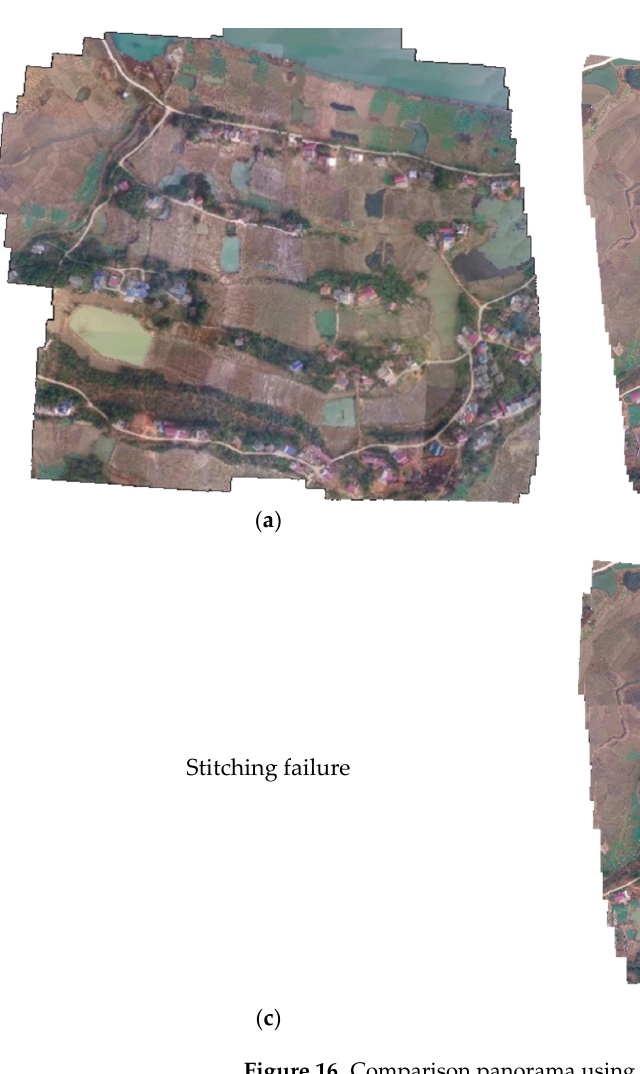
( d ) Figure 17. Comparison of road in panorama using di ff erent methods. ( a ) QuickBird. ( b ) AutoPano. ( c ) Opencv-Stitcher. ( d ) Ou r method.